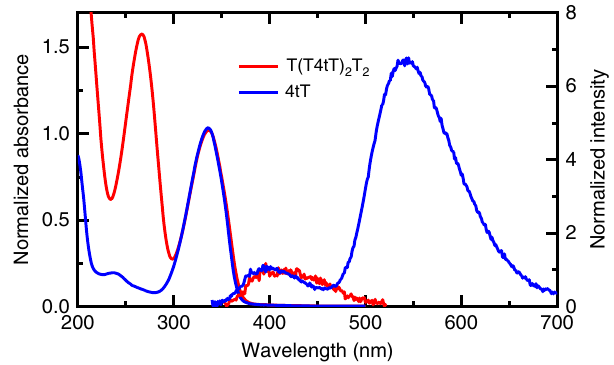
Fig. 2 Normalized absorption and emission spectra for 4tT and T (T4tT) 2 T 2 . Room-temperature absorption and emission spectra for 4tT in PBS at pH 7.4 are shown using blue lines, while those for T(T4tT) 2 T 2 are depicted using red lines. We remark that the emission spectrum for T(T4tT) 2 T 2 has a very small intensity and may not be measured accurately within the sensitivity of the spectro fl uorometer used in this work. Photoexcitation was performed at 340 ca. 336 nm, which is slightly red shifted in T(T4tT) 2 T 2 compared